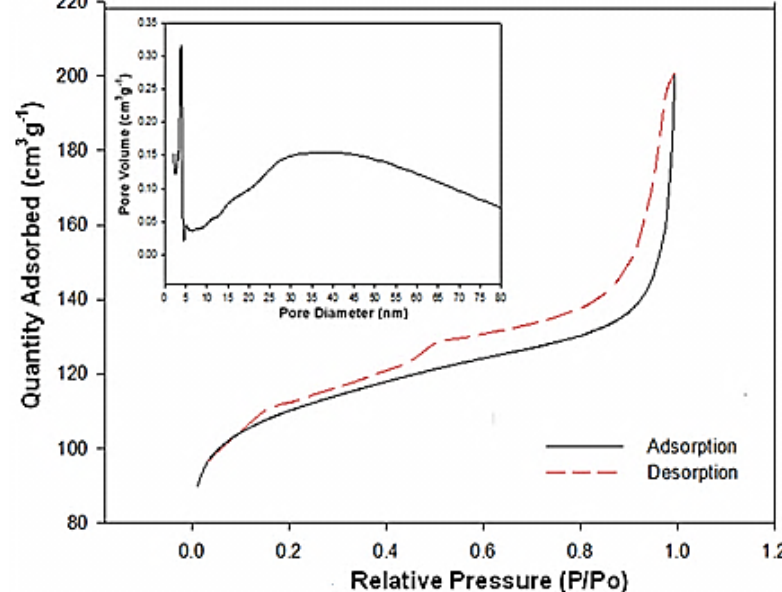
Figure 4. Nitrogen sorption isotherms of MnO 2 /C composites. The insert is the Barrett–Joyner– Halenda (BJH) desorption pore size distribution. (BJH) desorption pore size